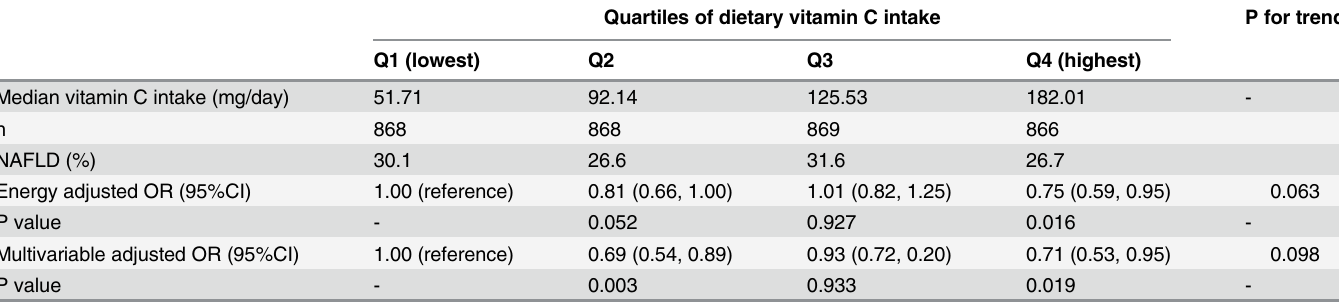
Table 2. Energy and multivariable adjusted relationship between dietary vitamin C intake and NAFLD. Quartiles of dietary vitamin C